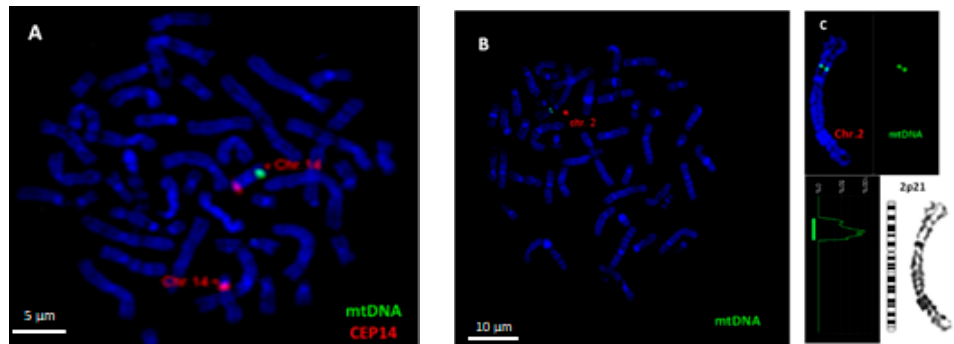
Figure 2. Fluorescence in situ hybridization (FISH) analysis of mtDNA insertion in chromosomes of human peripheral blood lymphocytes. ( A ) Hybridization of a homemade mtDNA probe (spectrum green) with chromosome 14q31 of a healthy person with confirmed mtDNA insertion (positive control). Localization of mtDNA insertion on chromosome 14 was confirmed using CEP 14 probe (spectrum orange). ( B ) mtDNA insertion (spectrum green) on chromosome 2 after treatment with DOX at a concentration of 0.025 µg/mL. ( C ) Karyotyping revealed the localization of mtDNA fragment on 2p21. Chromosomes are counterstained with DAPI. Scale bar = 5 µm ,10 µm